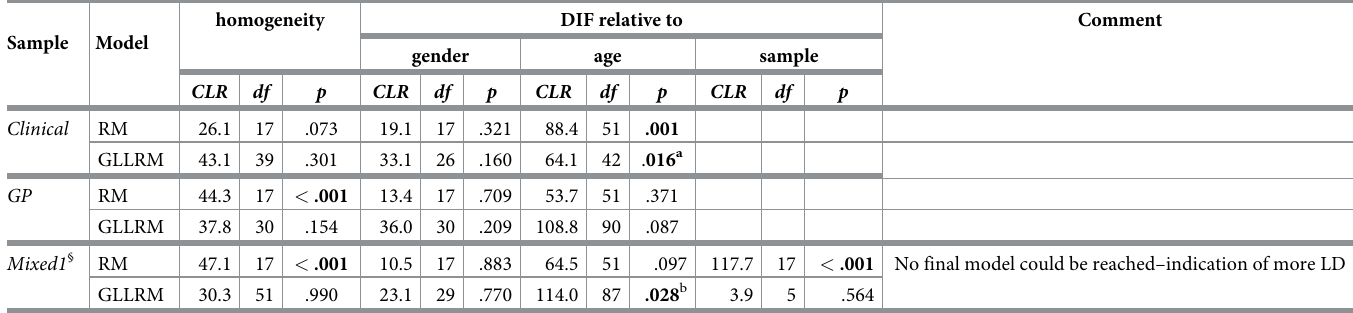
Table 2. PB-subscale (4 response categories): Global test-of-fit and global-tests-of-no-DIF relative to gender, age group and sample. Sample